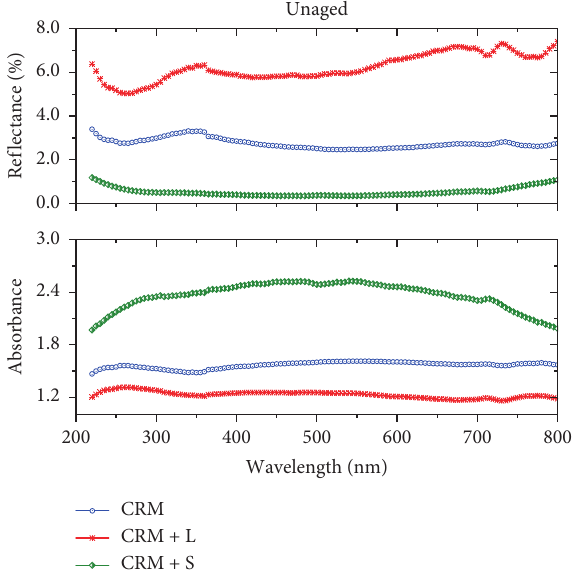
Figure 2: Reflectivity and absorbance of unaged warm asphalt binders.